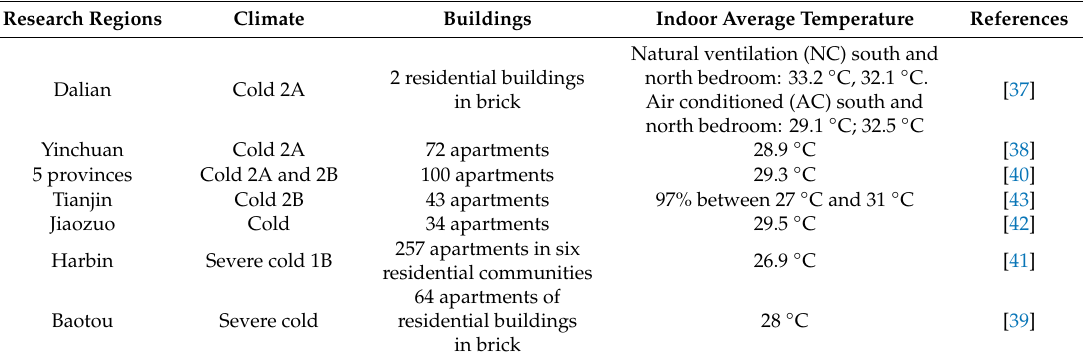
Table 2. Summary of results from thermal comfort investigations in residential buildings in China. Research